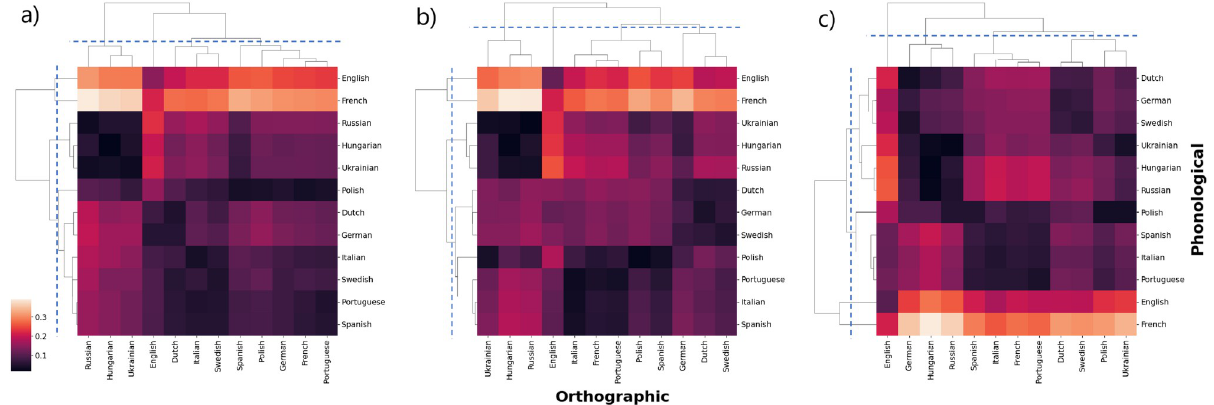
Fig 4. Language similarity evaluated by the Jensen-Shannon distance between layers orthographic (horizontal) and phonological (vertical). The cases of (a) ℓ = 1, (b) ℓ = 2 and (c) ℓ = 3 are depicted. The dendograms have been determined in terms of the similarities between languages by using the agglomerative hierarquical clustering method. We observe that for ℓ = 1 and ℓ = 2, the dendogram for the orthographic dimension at intermediate height (dashed line), four groups are identified, G1 (Russian, Hungarian and Ukranian) is the one which exhibits the highest internal similarity (low JSD); the other three groups correspond to G2 (English), G3 (Dutch, Italian and Swedish), G4 (Spanish, Polish, German and Portuguese). It is important to notice that in groups G3 and G4, Romance, Germanic and Slavic families are mixed and English is an isolated language. In contrast, for the phonological dimension, the JSD values at an intermediate cut-off (dashed line), also four groups are again observed, being the English and French the ones that stands out for a large distance with any other language, while Ukranian, Russian and Hungarian are described by relatively low distances. For ℓ = 3, we observe that English is the most divergent from the rest in terms of writing, while English and French are the most divergent in terms of phonological structure.